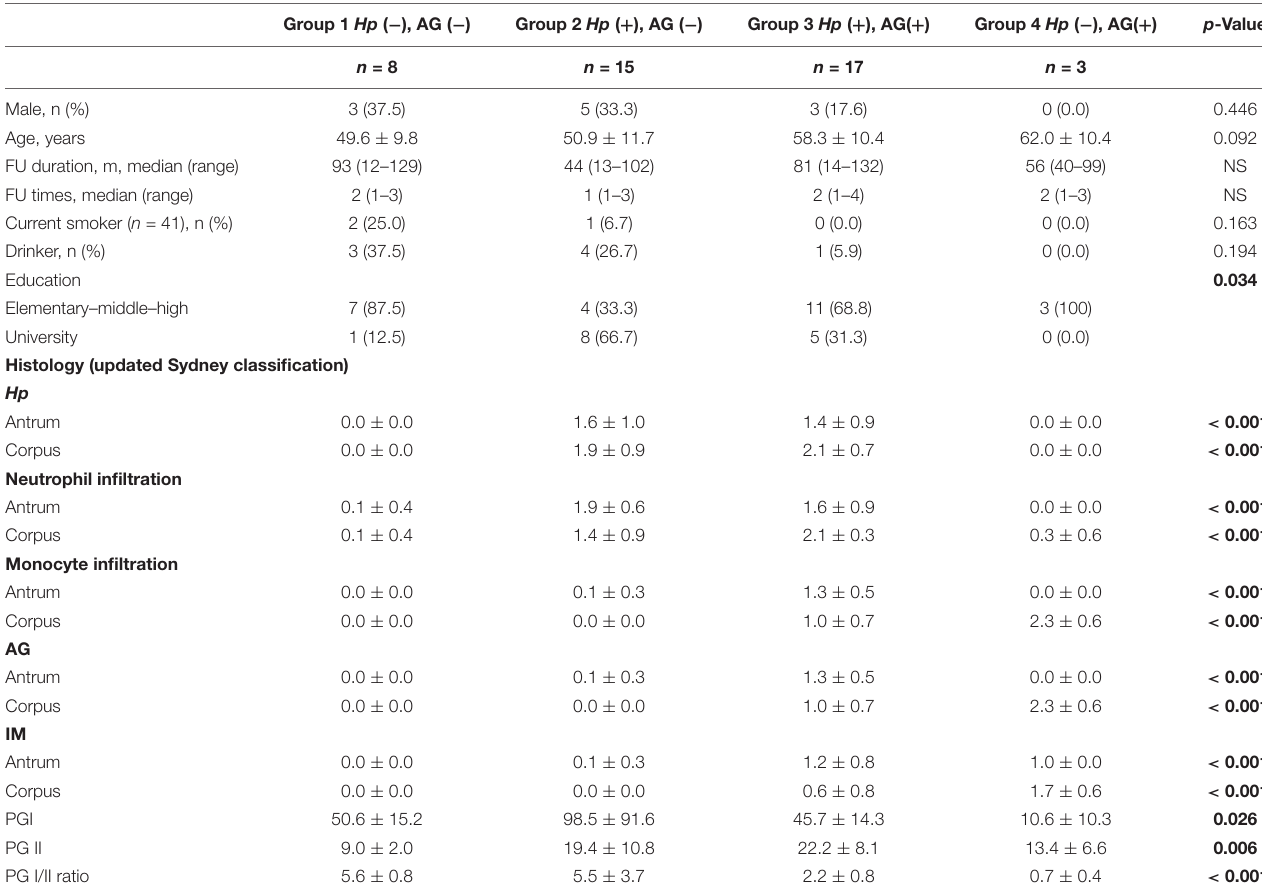
TABLE 1 | Baseline characteristics of the study subjects ( N =